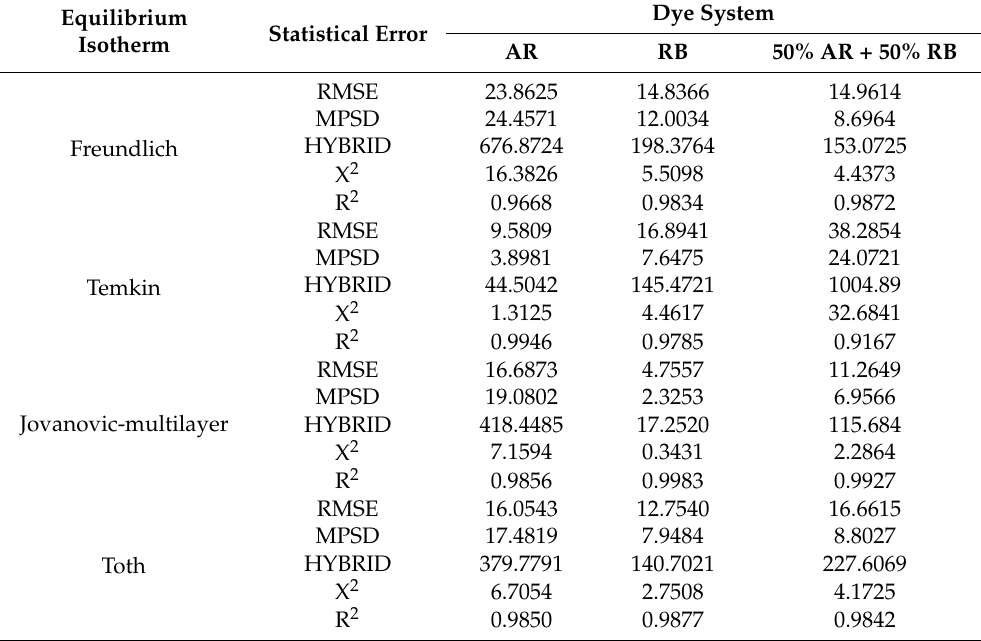
Table 6. Statistical error function values of equilibrium isotherm nonlinear